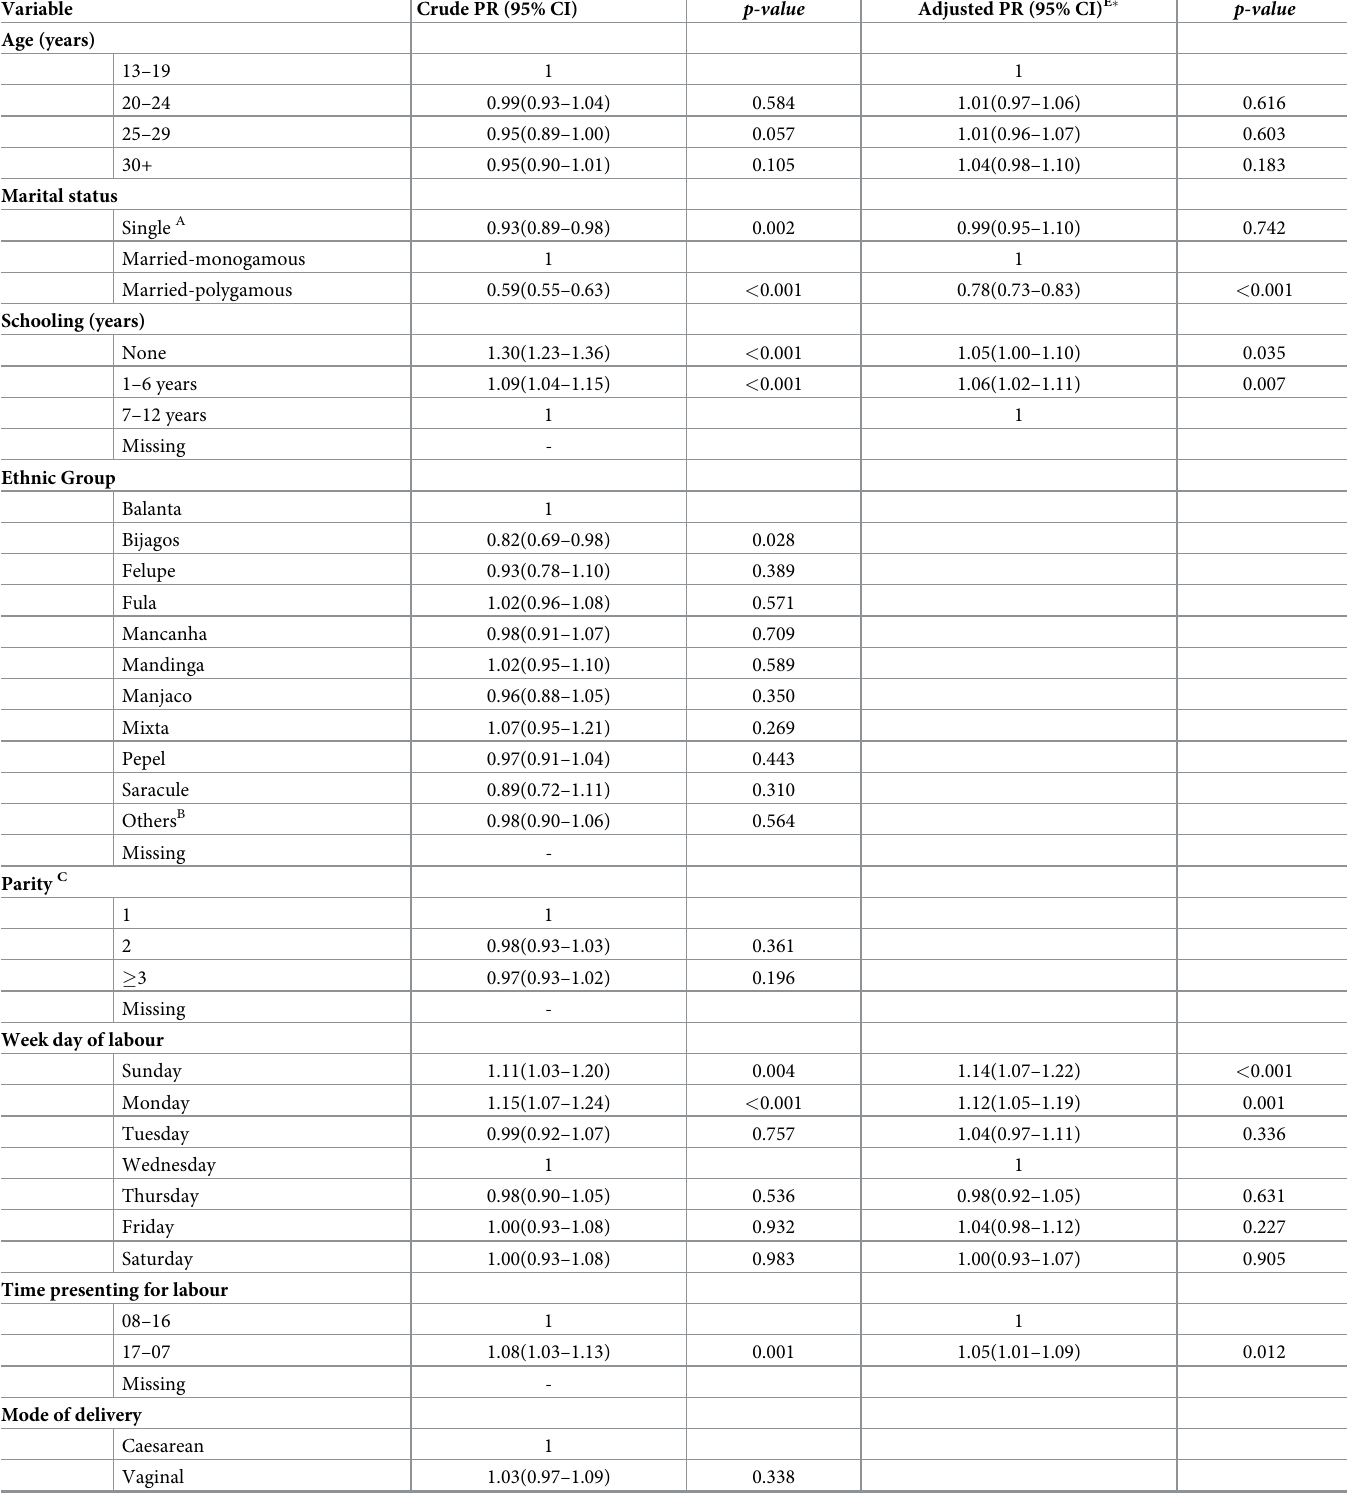
Table 2. Crude and adjusted prevalence ratios for not testing for HIV among pregnant